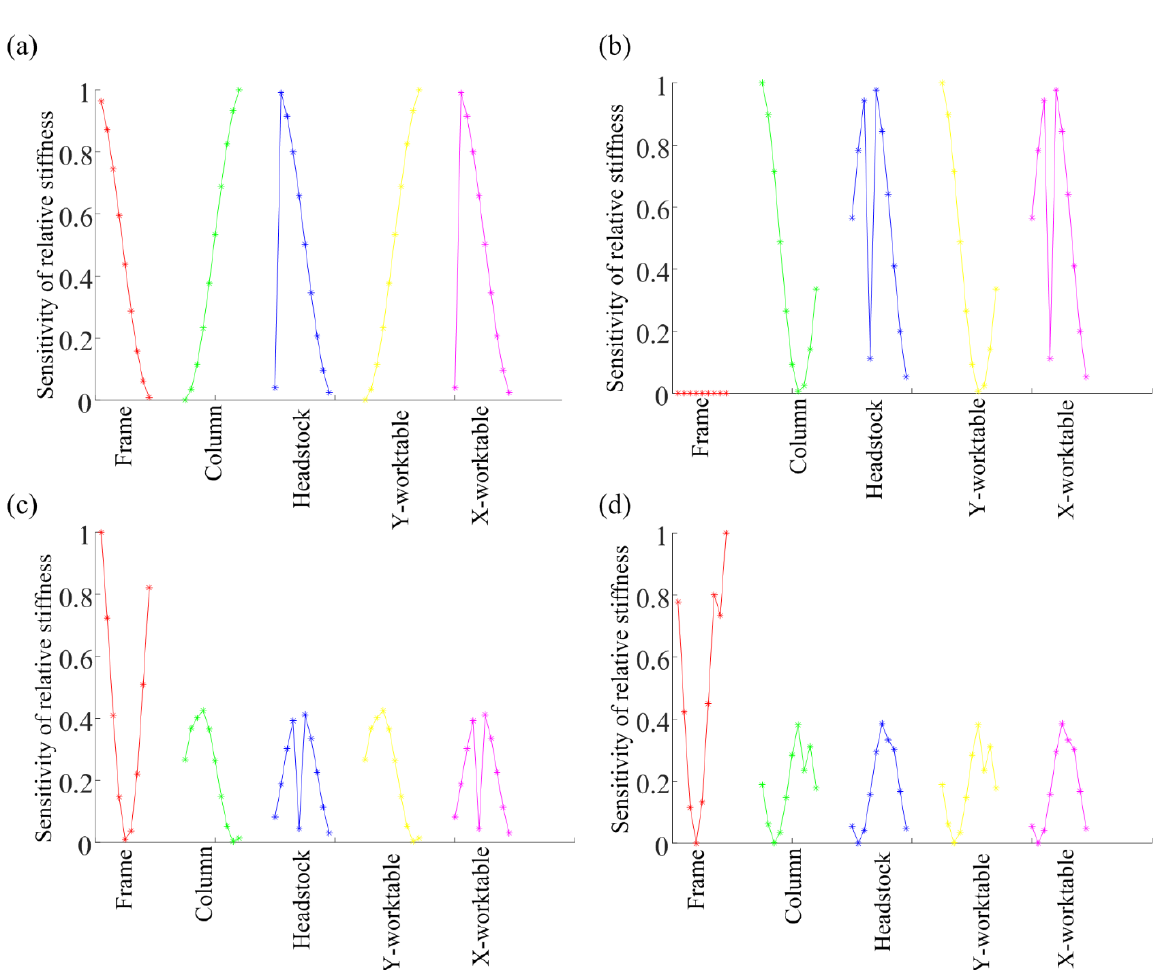
Figure 2. In case A, the modal dynamic stiffness sensitivity of each degree of freedom: ( a ) the first order, ( b ) the second order, ( c ) the third order, and ( d ) the fourth order.